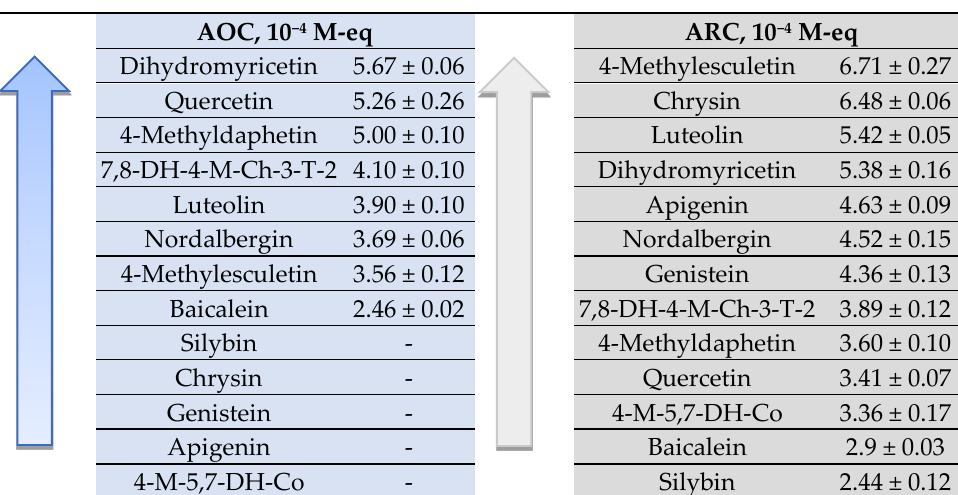
Chemosensors 2021 , 9 , x FOR PEER Table 4. AOC and ARC of flavonoids and coumarins (C AO = 10 − 4 M, n = 5, p = 0.95).